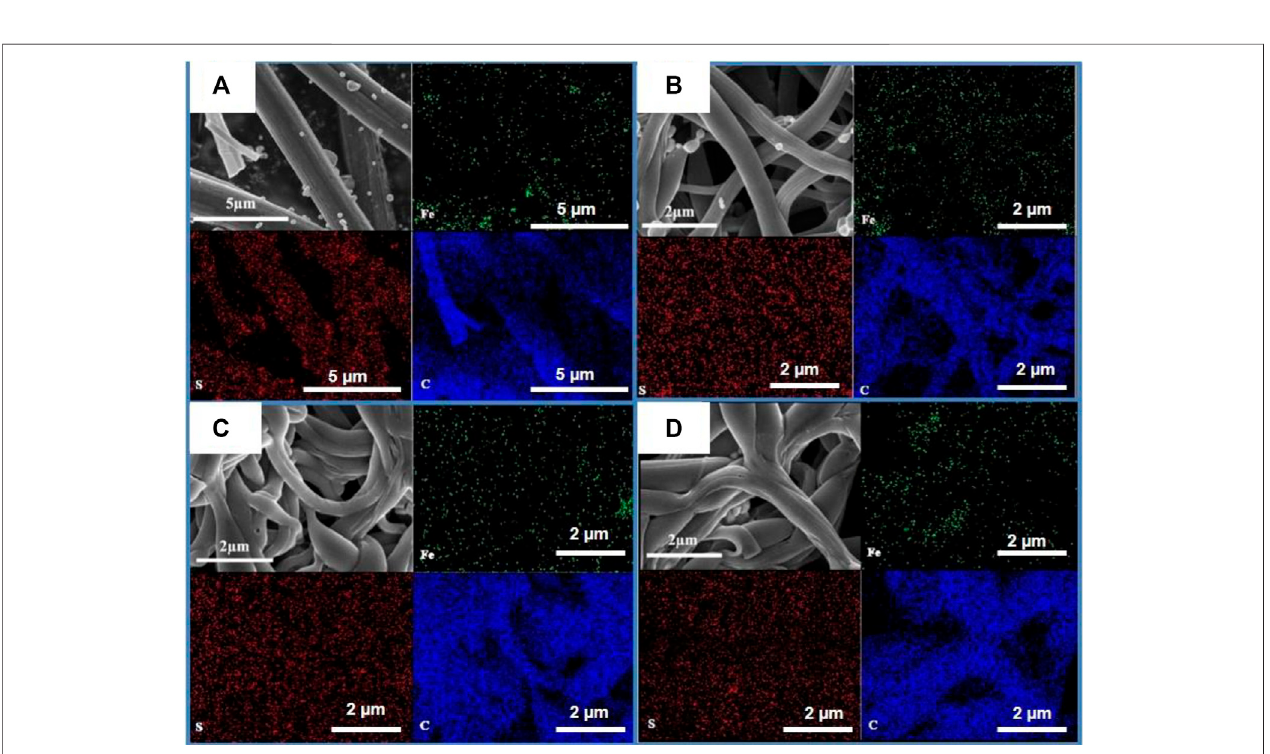
Frontiers in Chemistry |